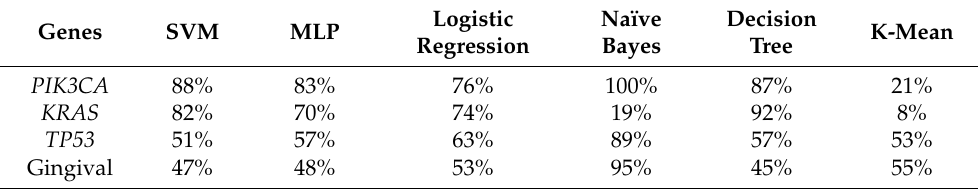
Table 2. Accuracies through 5-fold classification on different algorithms for the 4